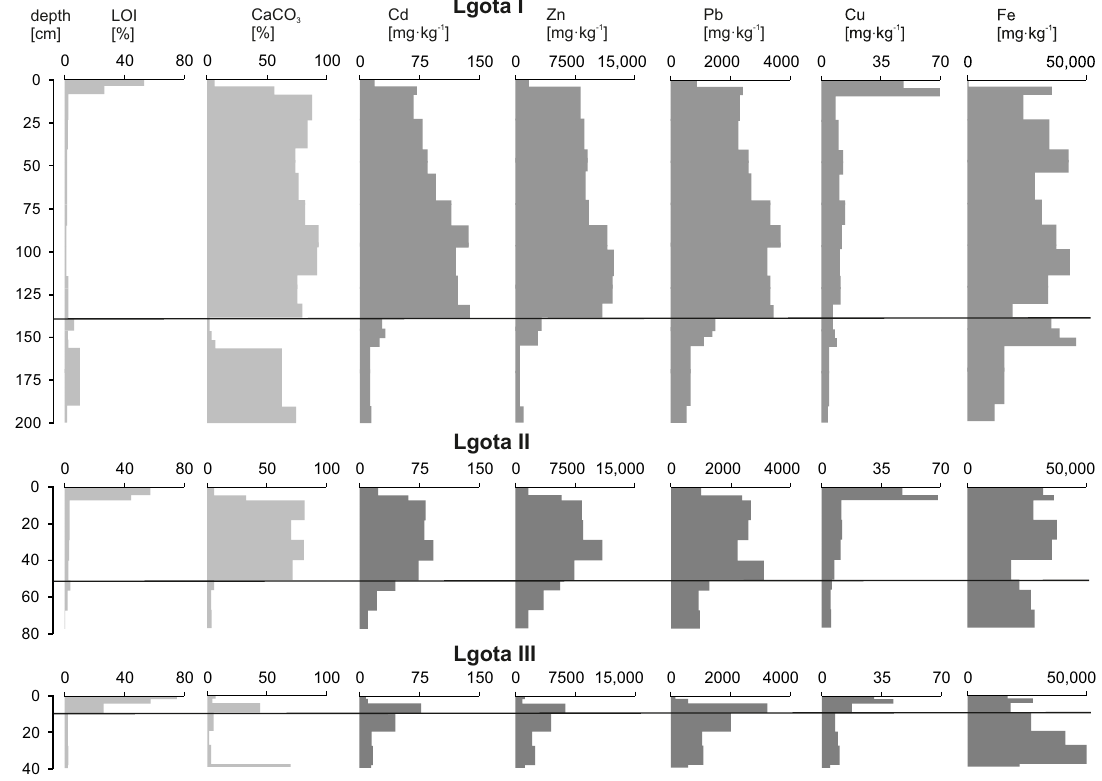
Figure 4. Distribution of selected elements in the profiles at the Lgota heap (lines show former soil